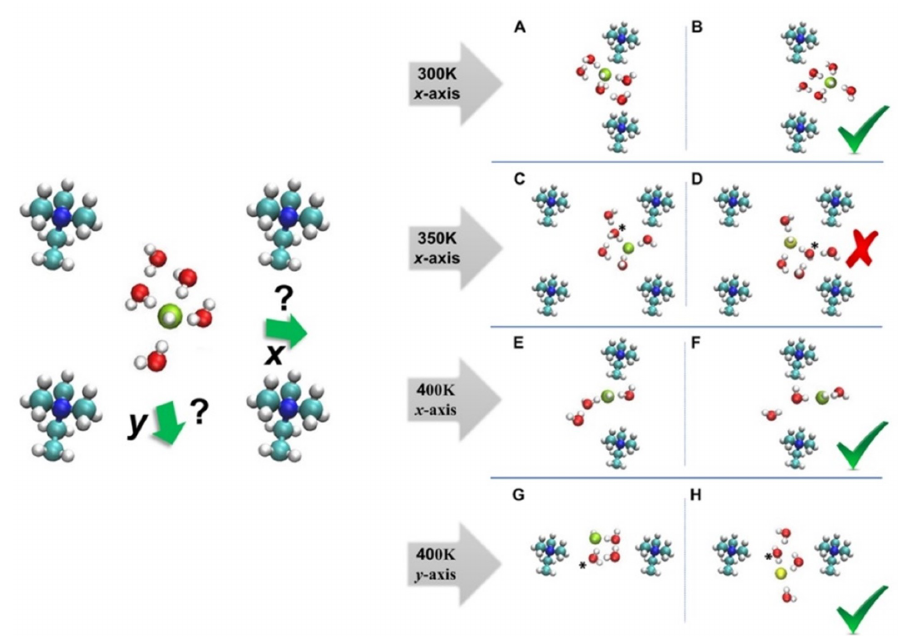
Figure 7. The various configurations for designed distribution of water in AEM at the different axis. Green and yellow spheres represent the initial and final hydroxide ion oxygen atoms, respectively. ( A , B ) OH − exhibits vehicular diffusion at room temperature, forming a stable OH − ( H 2 O ) 5